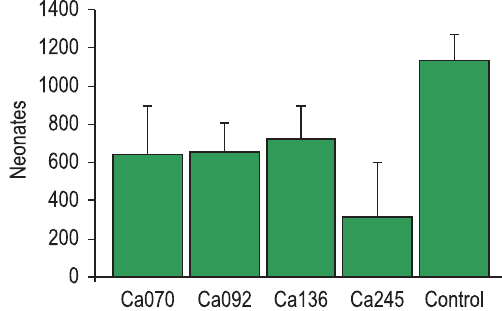
Figure 4. Mean number of neonates and standard deviation per point, considering the total number of